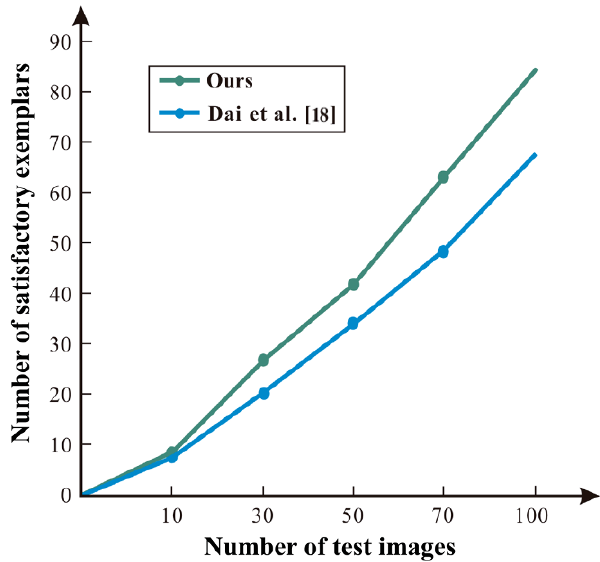
Fig. 10 Statistical comparison between Dai et al.’s method and